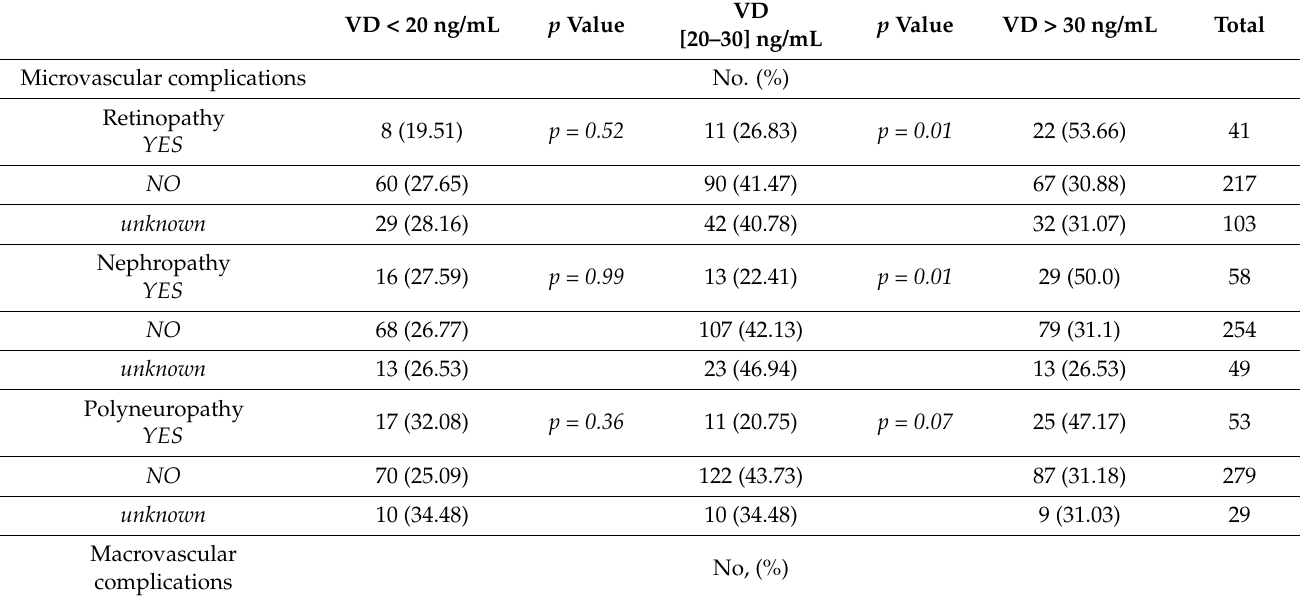
Table 2. Distribution of the number (No.) of patients by diabetes-related microvascular and macrovascular complications according to vitamin D